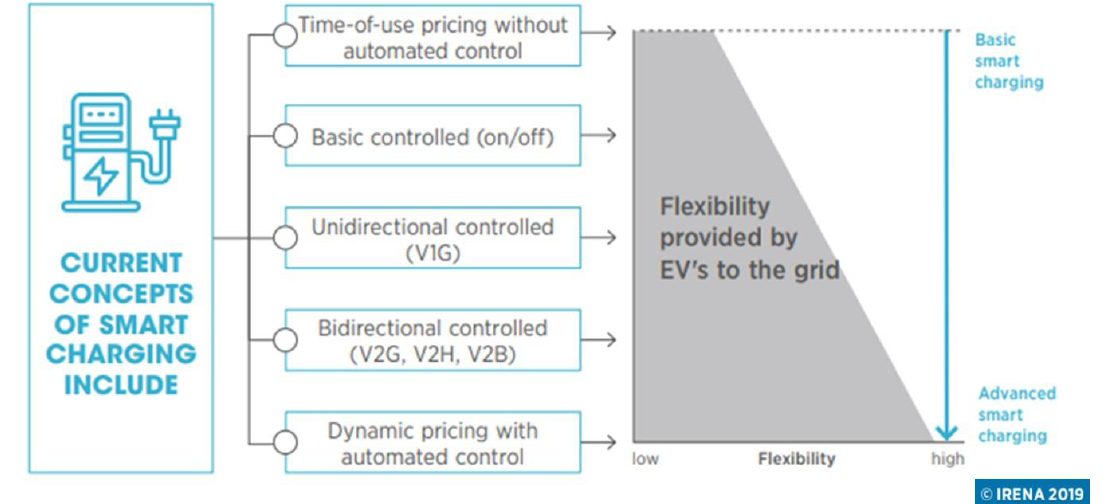
Figure 8. Smart charging as an enabler for EVs to provide flexibility to the grid. Reproduced from [72], IRENA: 2019.